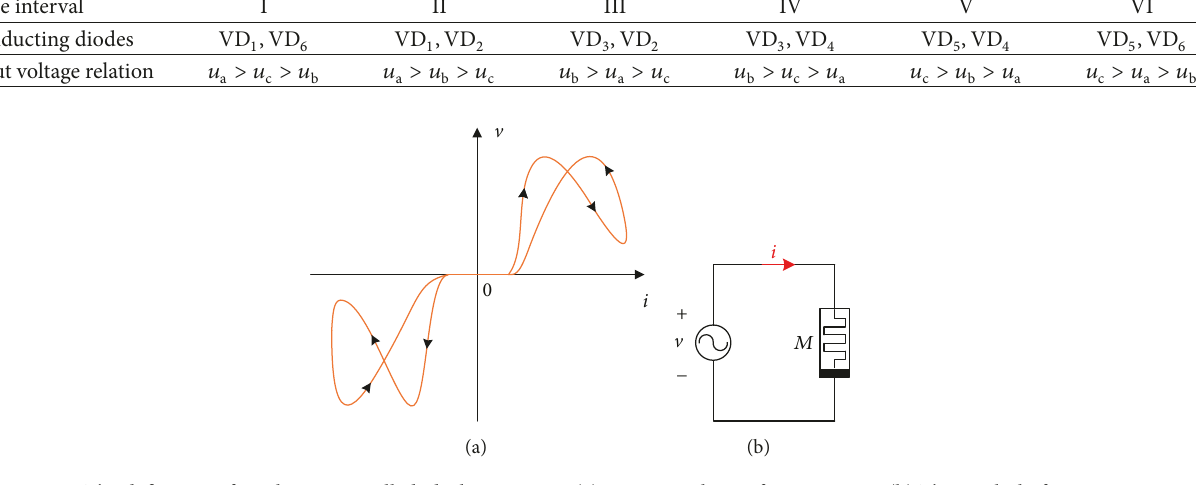
Figure 1: The definition of a voltage-controlled ideal memristor. (a) Hysteresis loop of a memristor. (b) The symbol of a memristor.